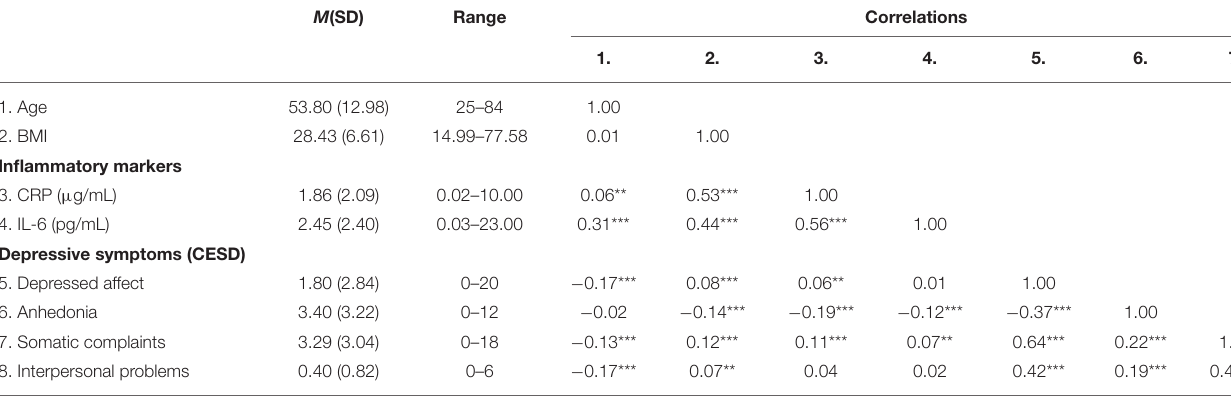
TABLE 2 | Descriptive statistics for key study variables and bivariate associations between